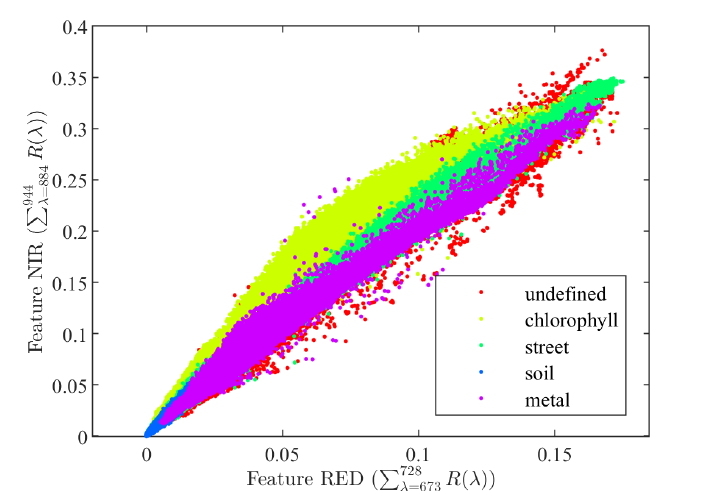
Figure 1. Normalized Difference Vegation Index (NDVI) features computed from the database of Winkens et al. [14].